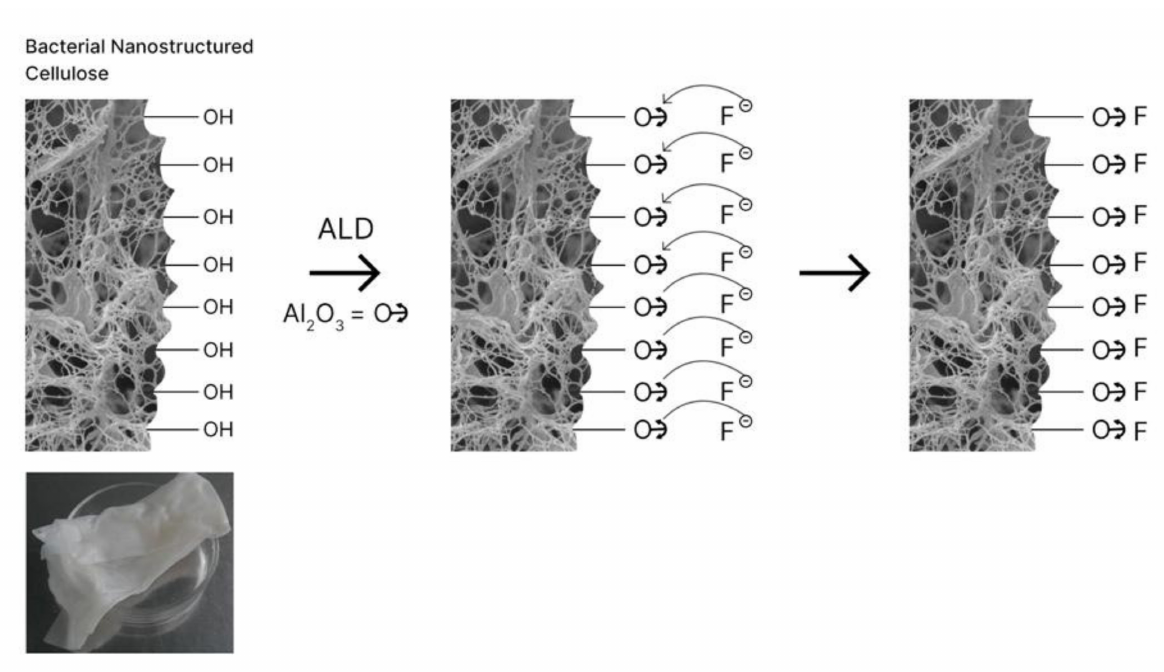
Figure 6. The scheme of the preparation process of biocomposites based on BC for the adsorption of fluoride. SEM images of BC and BC modified with aluminum oxide are shown in Figure 7.